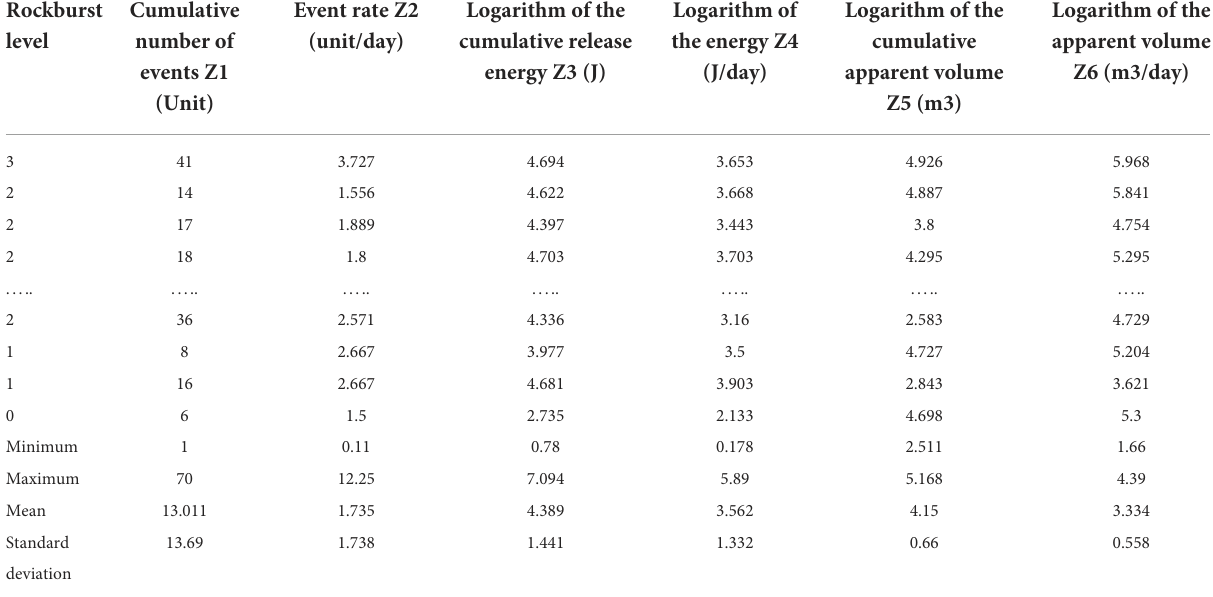
TABLE 2 The statistic of input and output feature in rockburst database.